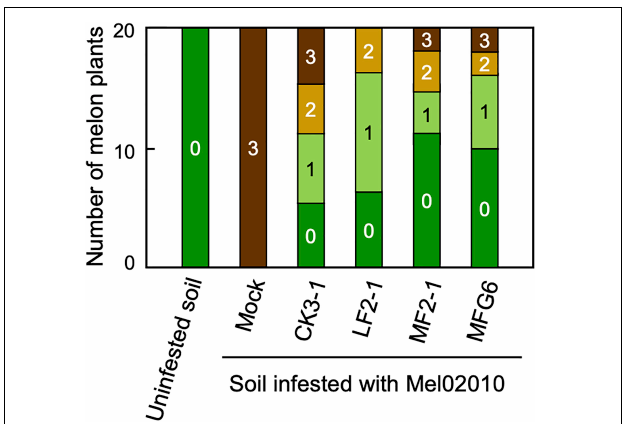
FIGURE 3 | Biocontrol activity of Fusarium oxysporum f. sp. lycopersici and its mutant (cid:49) FOW2 strain against F. oxysporum f. sp. melonis . Roots of melon seedlings were dipped in a conidial suspension (1 × 10 8 conidia/mL) of F. oxysporum f. sp. lycopersici strain CK3-1 or (cid:49) FOW2 strain LF2-1, and the seedlings were planted in soil infested with F. oxysporum f. sp. melonis strain Mel02010 (1 × 10 5 conidia/g soil). Control seedlings were immersed in water and planted in uninfested or infested soil (Mock). Symptoms were scored at 21 dpi as 0, no symptoms; 1, yellowing; 2, wilted; 3, dead. MF2-1, (cid:49) FOW2 strain of F. oxysporum f. sp. melonis ; MFG6, nonpathogenic F. oxysporum .